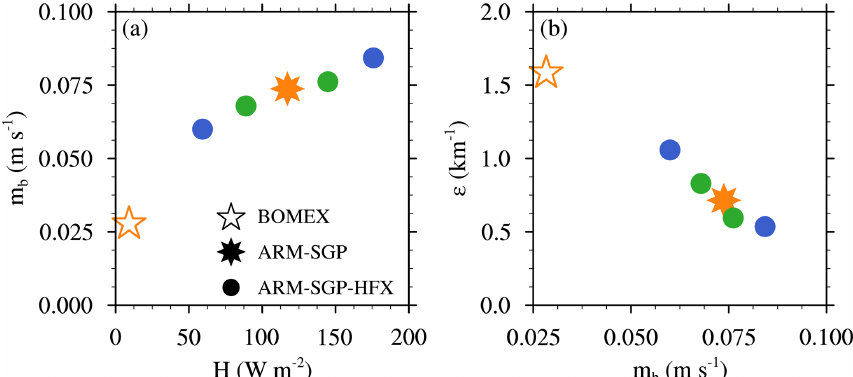
Figure 13. (a) The cloud-base mass flux ( m b ) as a function of sensible heat flux ( H ) and (b) the dilution rate ( ε ) averaged over the central 50% of the cloud layer as a function of m b for BOMEX and ARM-SGP as well as the ARM-SGP-HFX